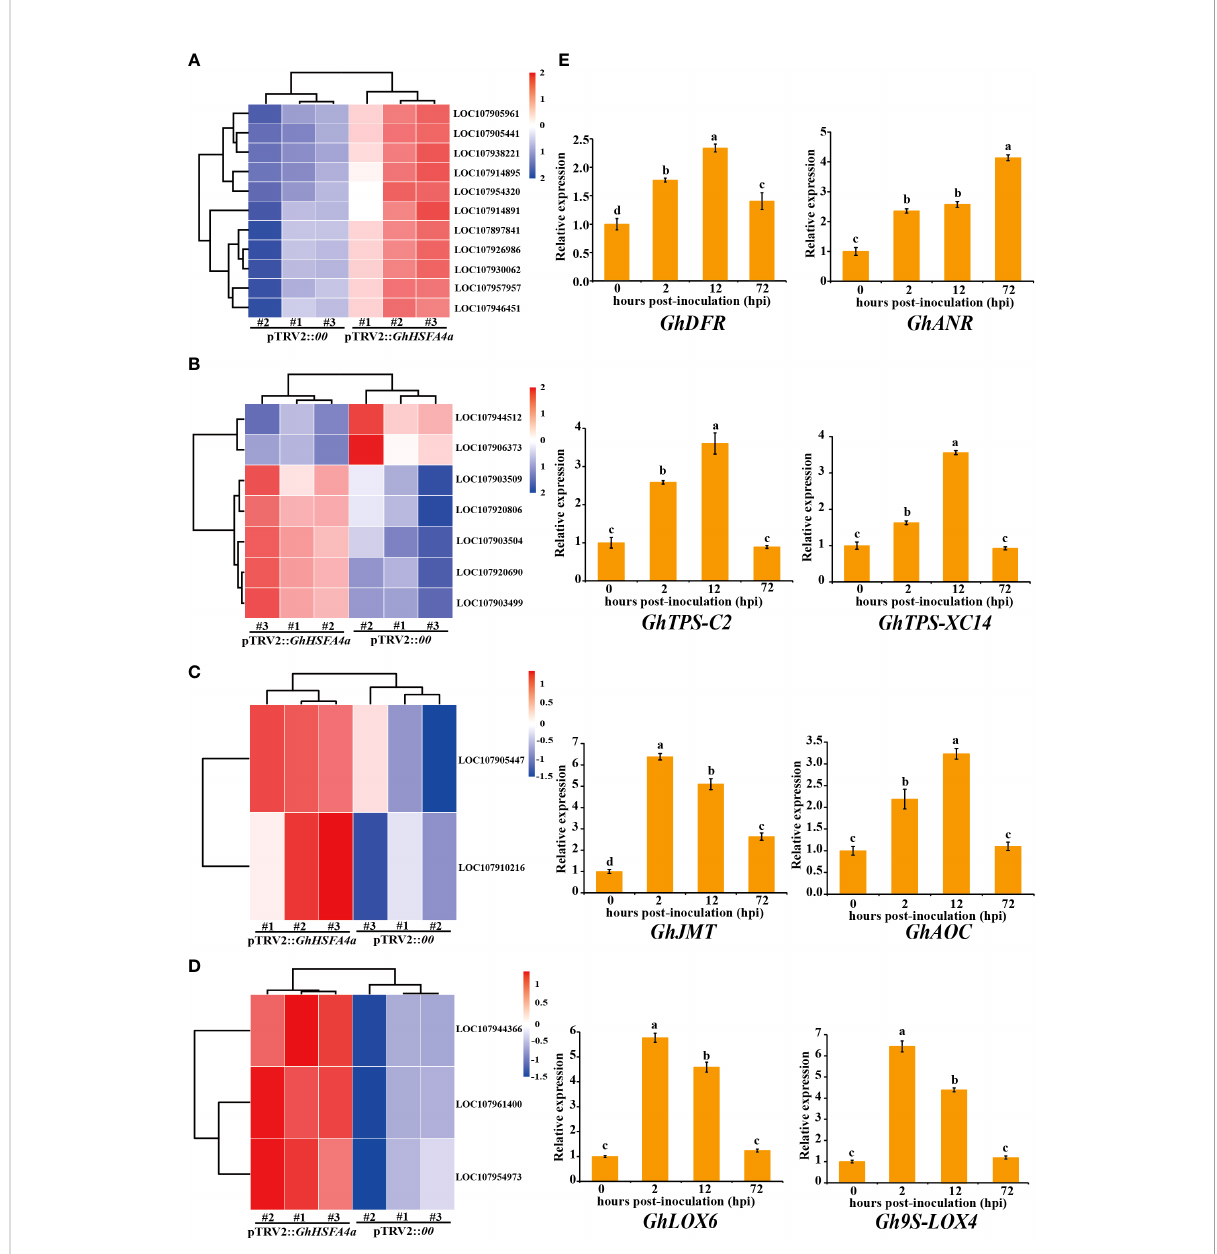
FIGURE 7 Validation of metabolic pathways signi fi cantly enriched for DEGs in pTRV2:: GhHSFA4a cotton. Detailed expression pro fi les of genes related to (A) “ fl avonoid biosynthesis ” , (B) “ sesquiterpenoid and triterpenoid biosynthesis ” , (C) “ alpha-linolenic acid metabolism ” , and (D) “ linoleic acid metabolism ” . (E) Relative expression levels over time of marker genes for the four pathways. Error bars represent the standard deviations and different letters indicate signi fi cant differences at p